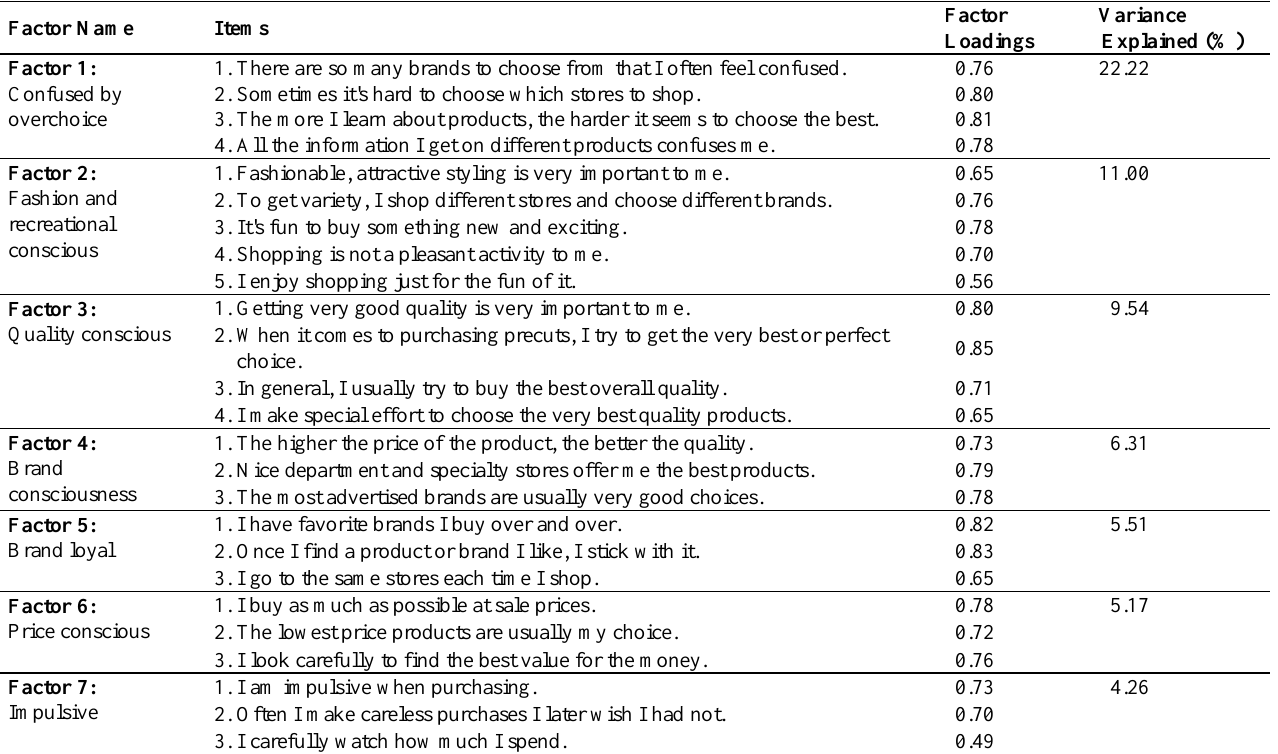
Table 3: Exploratory factor analysis results of decision-making styles Factor Name